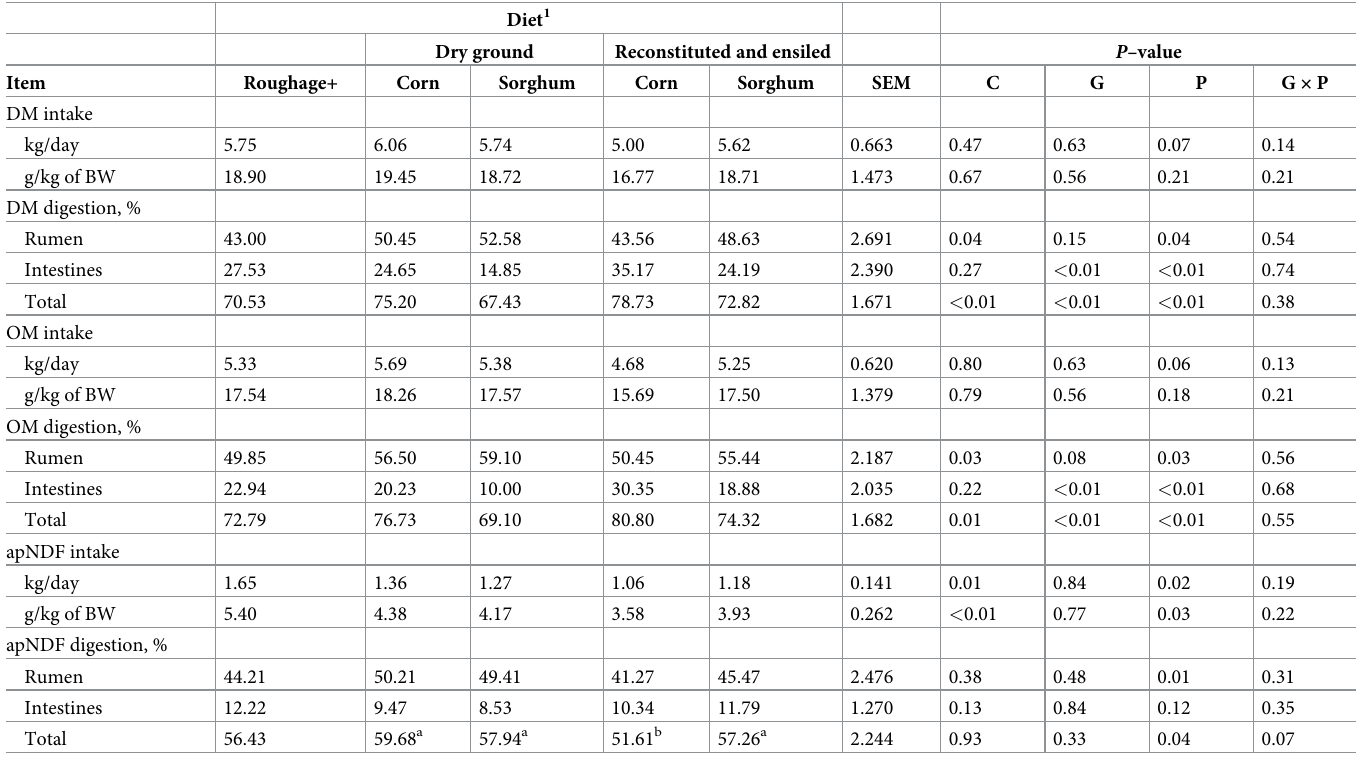
Table 2. Effect of concentrate level, grain source and processing method on Dry Matter (DM), Organic Matter (OM) and Neutral Detergent Fiber (apNDF) intake and digestibility of Nellore young bulls. Diet 1 Dry ground Reconstituted and ensiled P